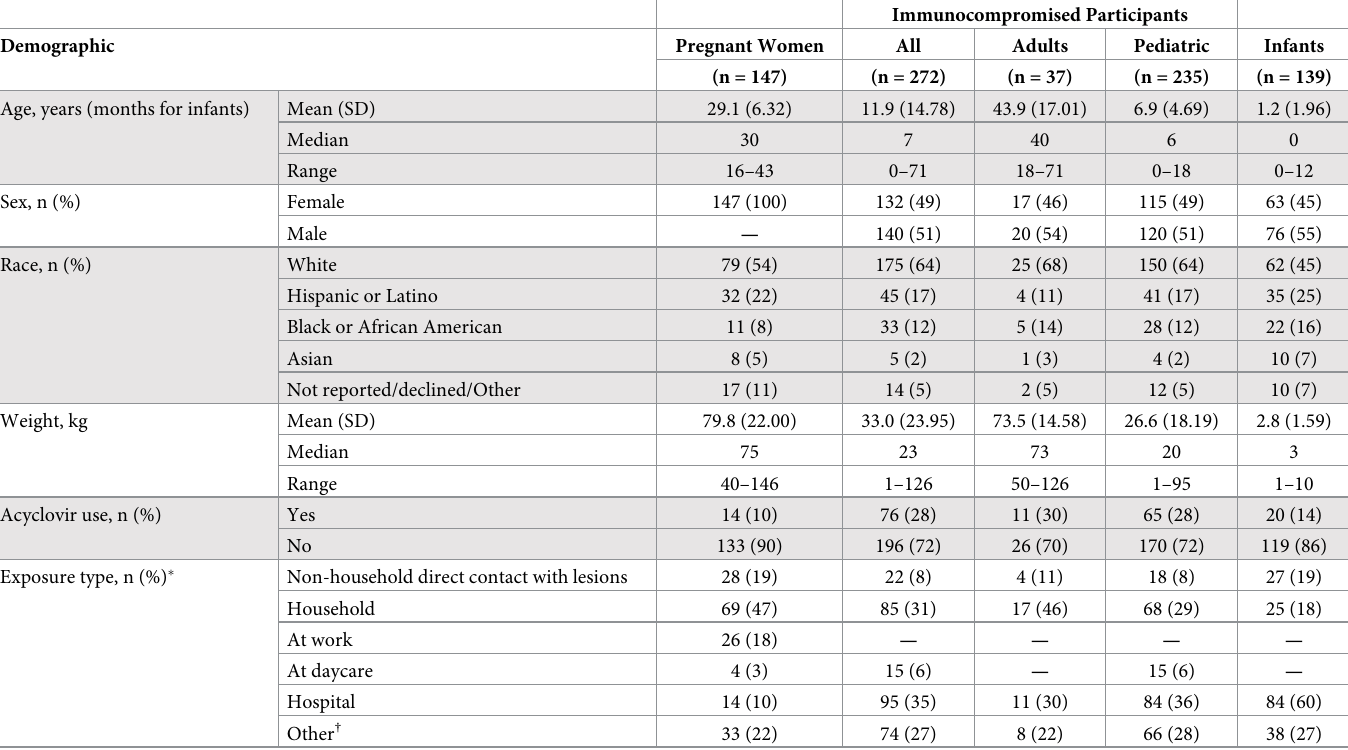
Table 2. Baseline demographics (safety population).